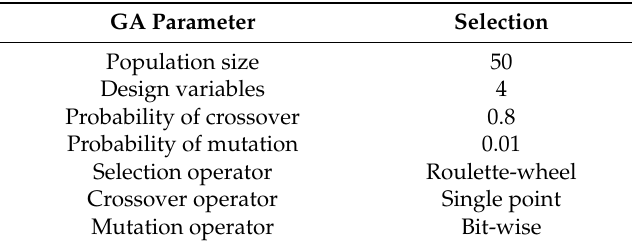
Table 1. GA parameters used for wet steam accumulator optimization.